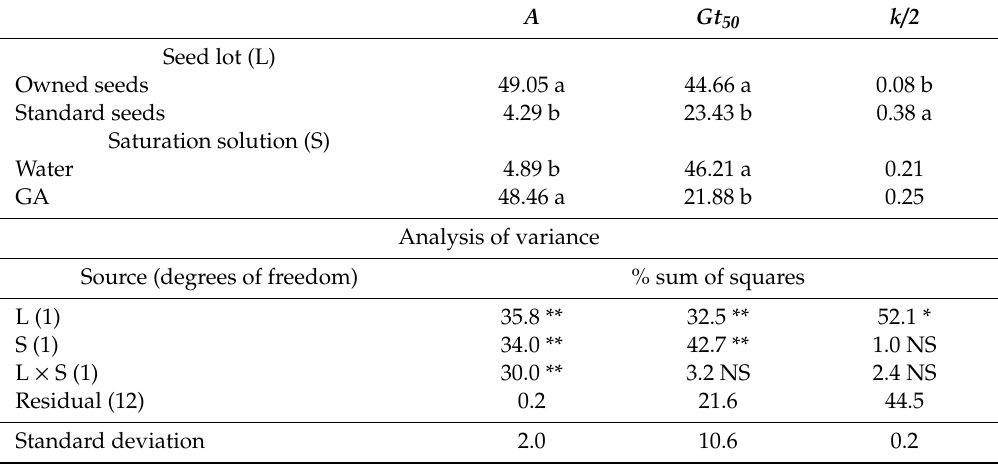
Table 7. E ff ects of the seed lot and the saturation solution on the germination parameters: The final germination percentage ( A , %), time (d) required to reach 50% of final germination ( Gt 5 0 ), and average germination rate ( k / 2 ; d − 1 ). Mean